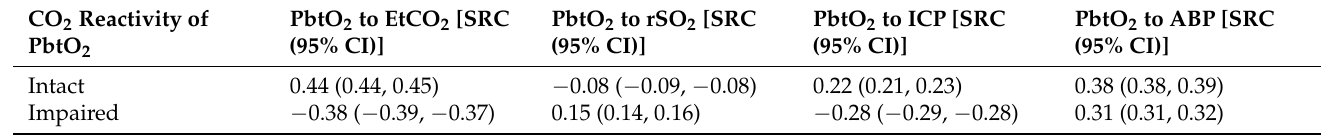
Table 4. Subgroup Analysis of Patients with Intact and Impaired CO 2 Reactivity of PbtO 2 .